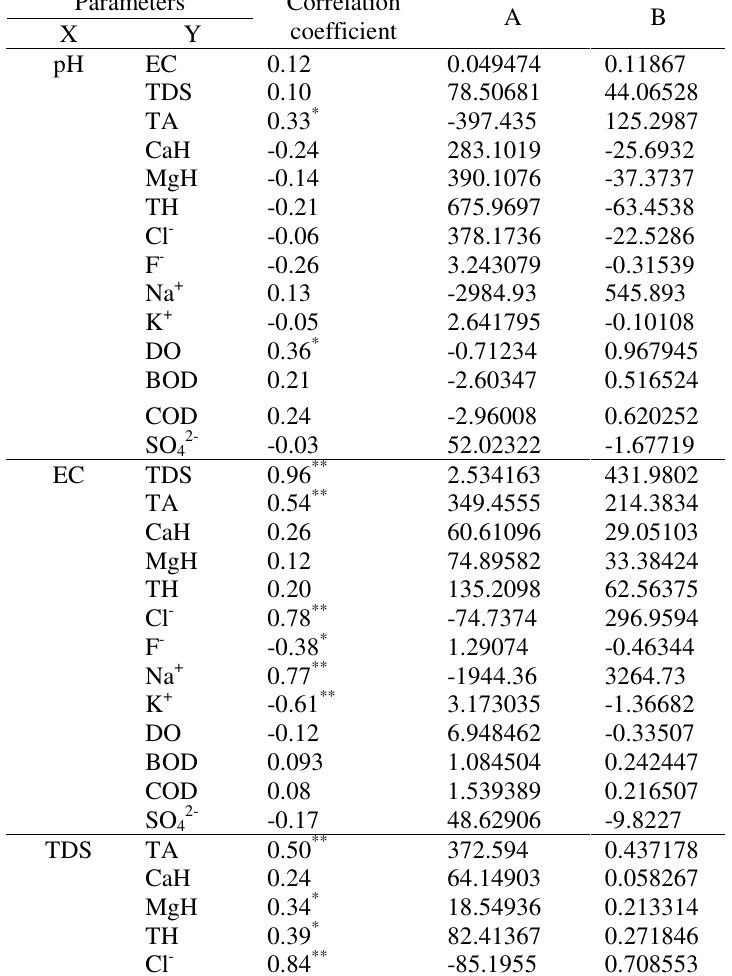
Table 9. Correlation coefficient and values of A and B of least square fitting of the equation Y=A+BX amongst various parameters of water samples of Gandhinagar